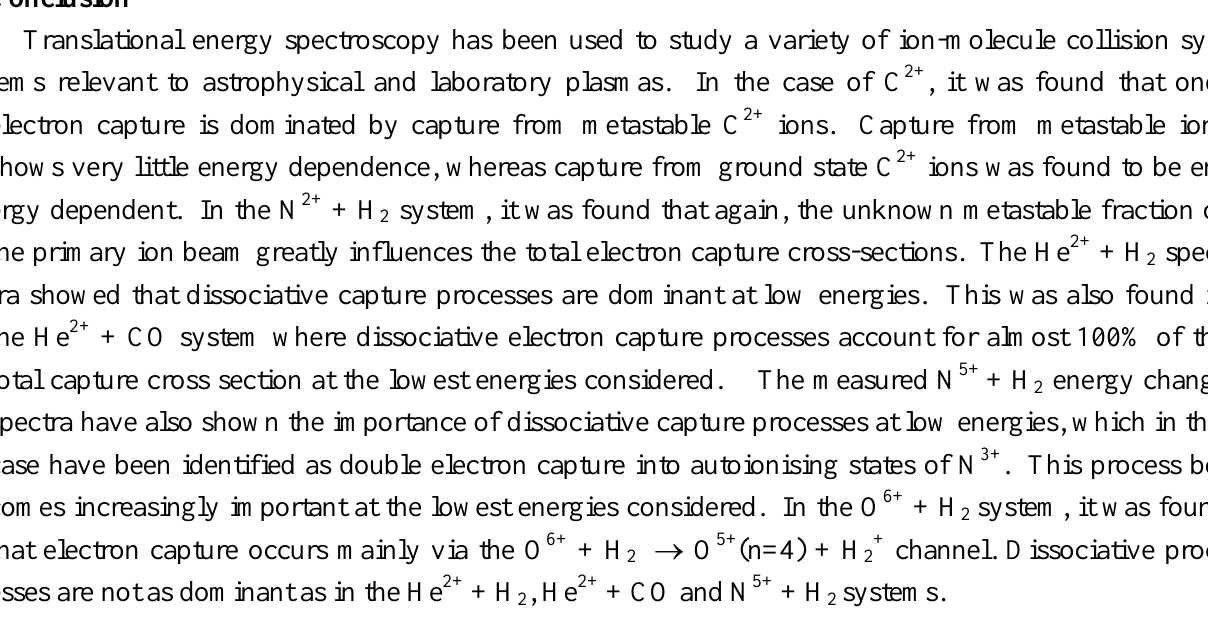
Table 6. Main product channels for the O 6+ (1s 2 ) 1 S + H